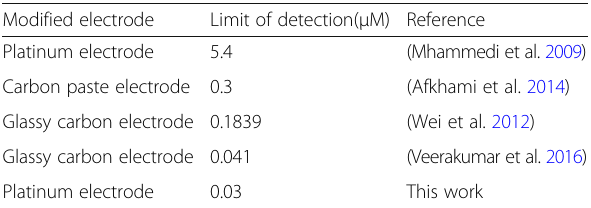
Table 3 Comparative studies of modified platinum electrode with other reported